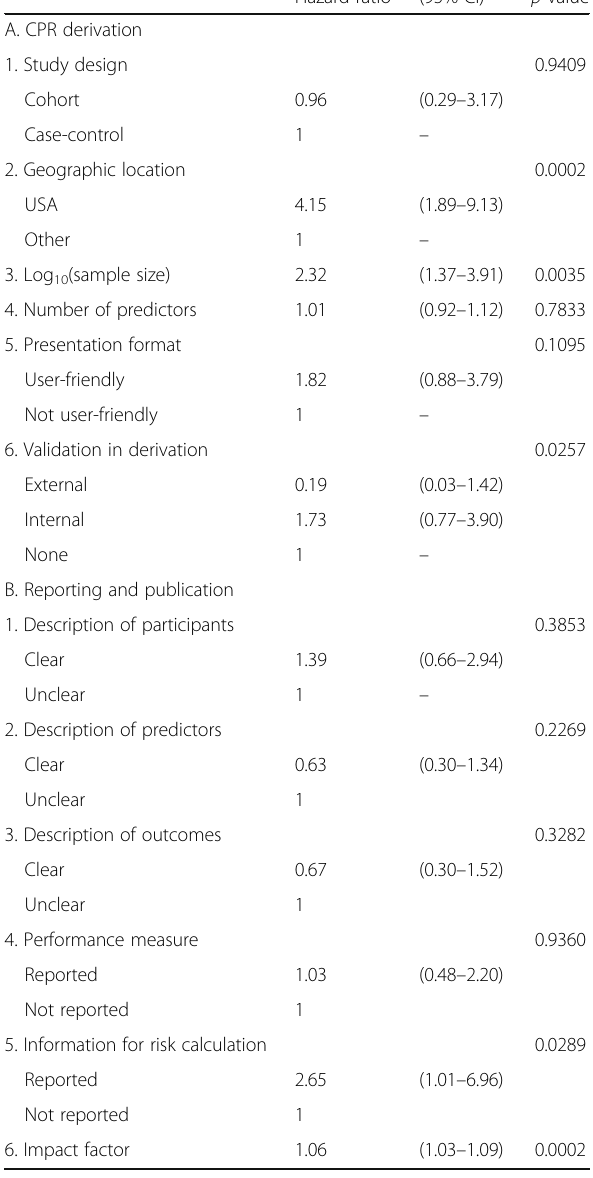
Table 2 Univariable Cox proportional hazards regression